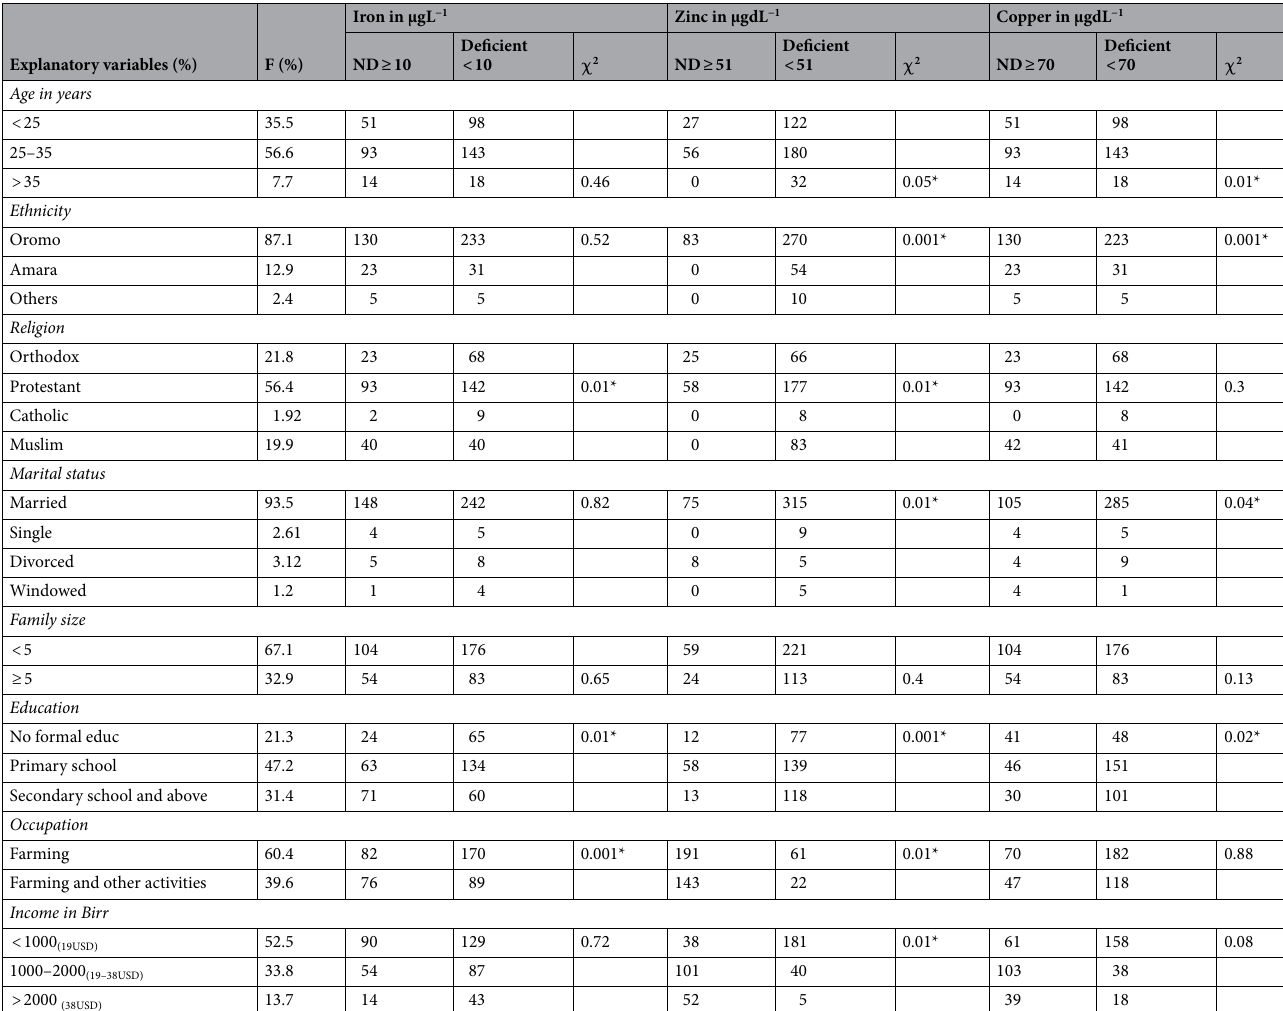
Table 1. Socio-demographic factors of pregnant women in Kellem Wellega zone, Western Ethiopia in 2021 χ 2 Chi square test, ND non-deficient, Educ. education, F frequency.